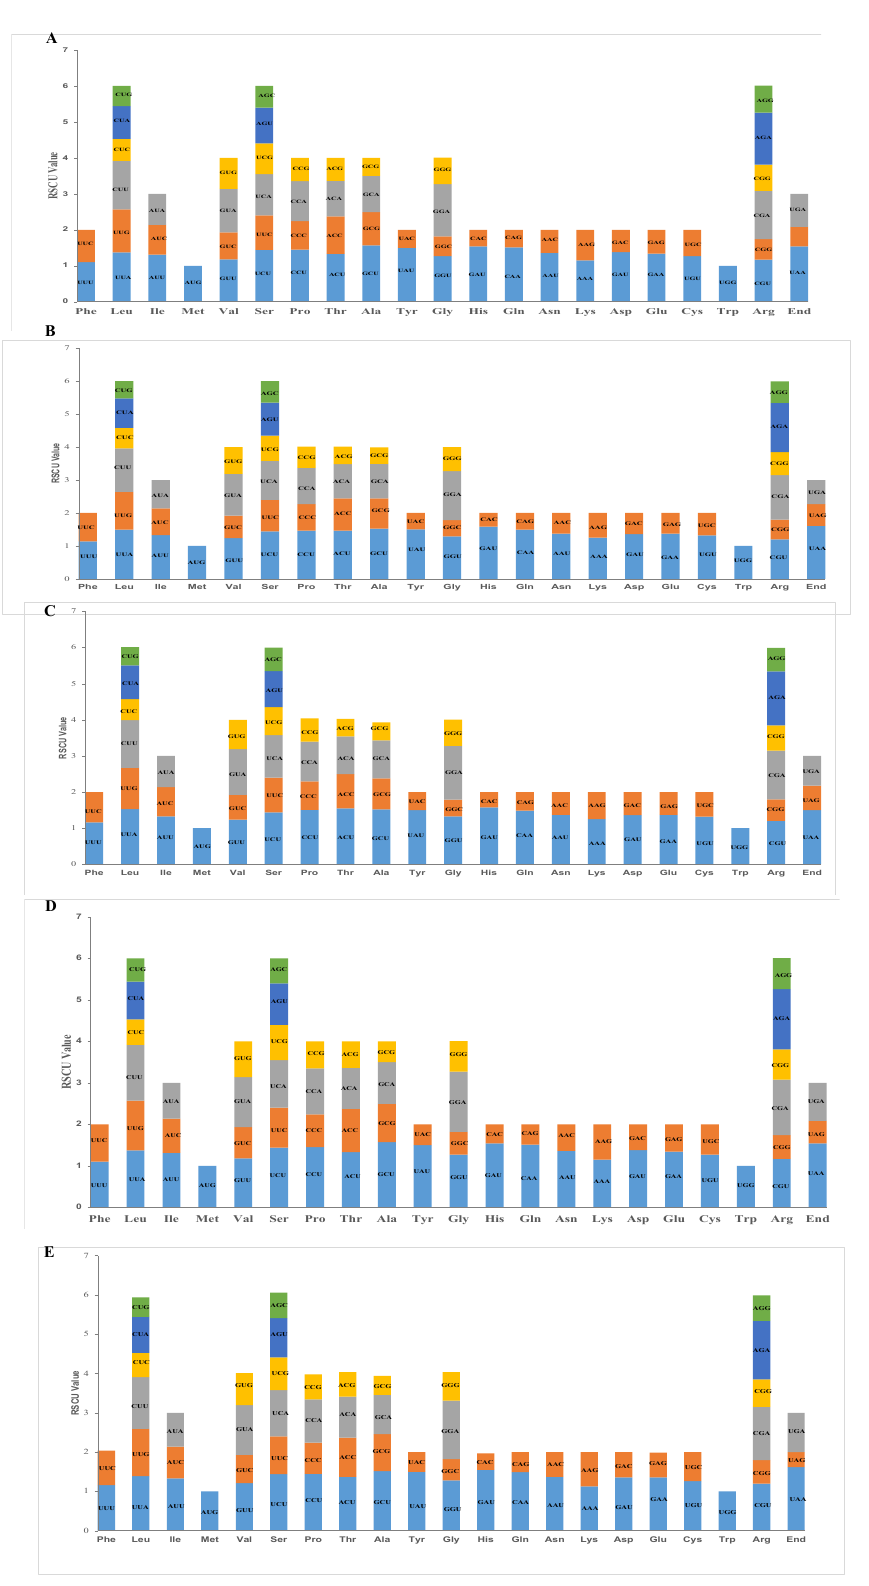
Figure 5. Relative synonymous codon usage (RSCU) in mitochondrial protein-coding genes of five Actinidiaceae mitogenomes. The y-axis represents the value for RSCU. ( A ) The RSCU value of A. chinensis (2 × ). ( B ) The RSCU value of A. chinensis (4 × ). ( C ) The RSCU value of A. chinensis var deliciosa (6 × ). ( D ) The RSCU value of A. eriantha . ( E ) The RSCU value of S. tristyla